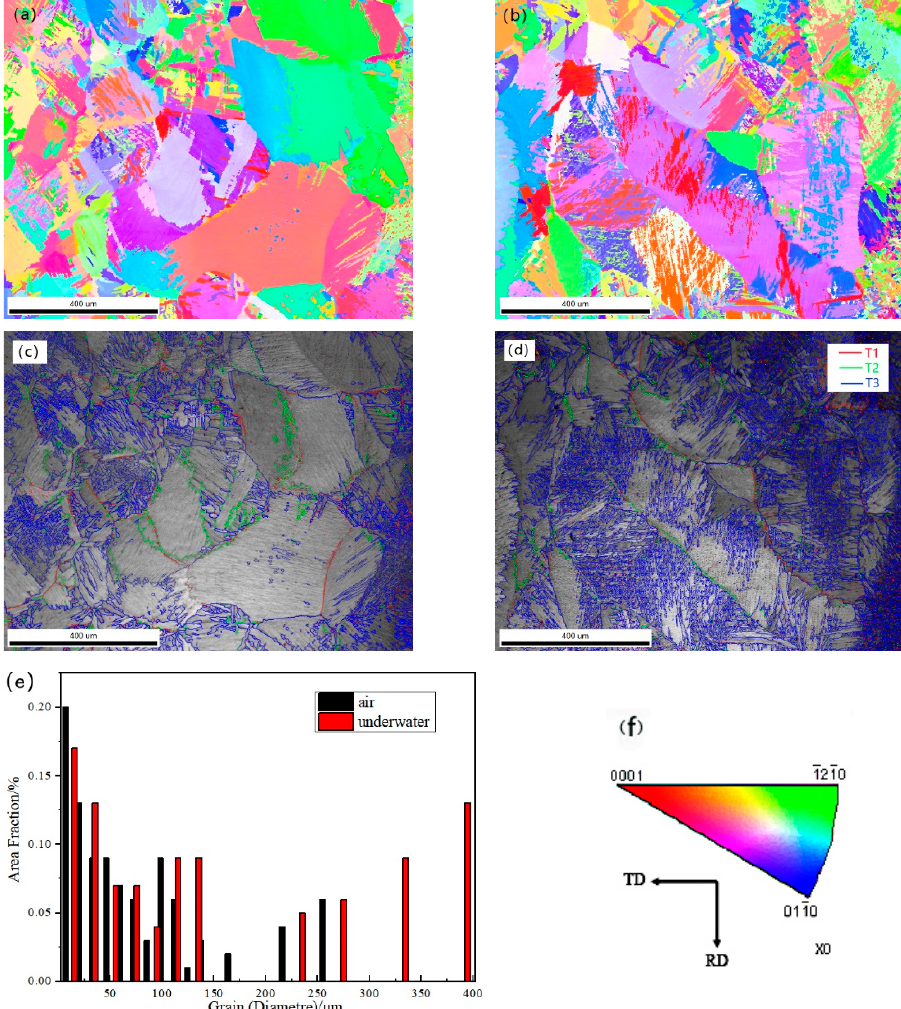
Figure 11. Underwater welding weld EBSD. ( a ) the IPF map of grains at the top of the weld; ( b ) the IPF map of grains at the bottom of the weld; ( c ) grain boundaries at the top of the weld; ( d ) the grain boundaries at the bottom of the weld; ( e ) grain sizes comparison ( f ) IPFs in the ND.